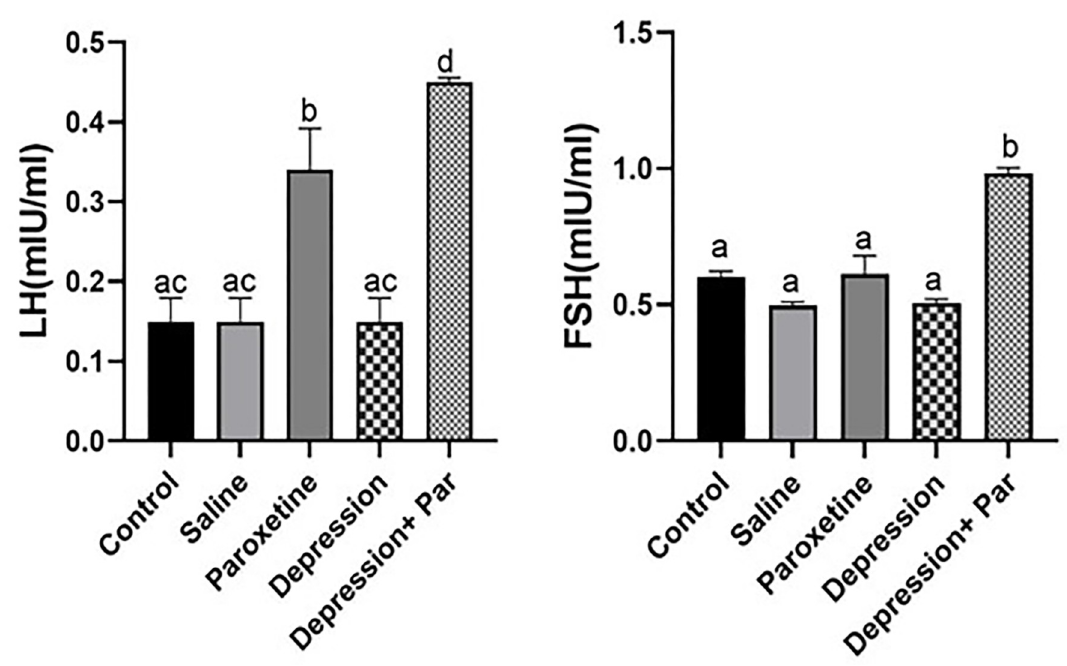
Fig 6. Comparison of serum follicle-stimulating hormone (FSH) and Luteinizing hormone (LH) levels in mouse serum between groups (N=3 for each group). Bars with different superscript letters are significantly different (p < 0.05). Par = paroxetine.